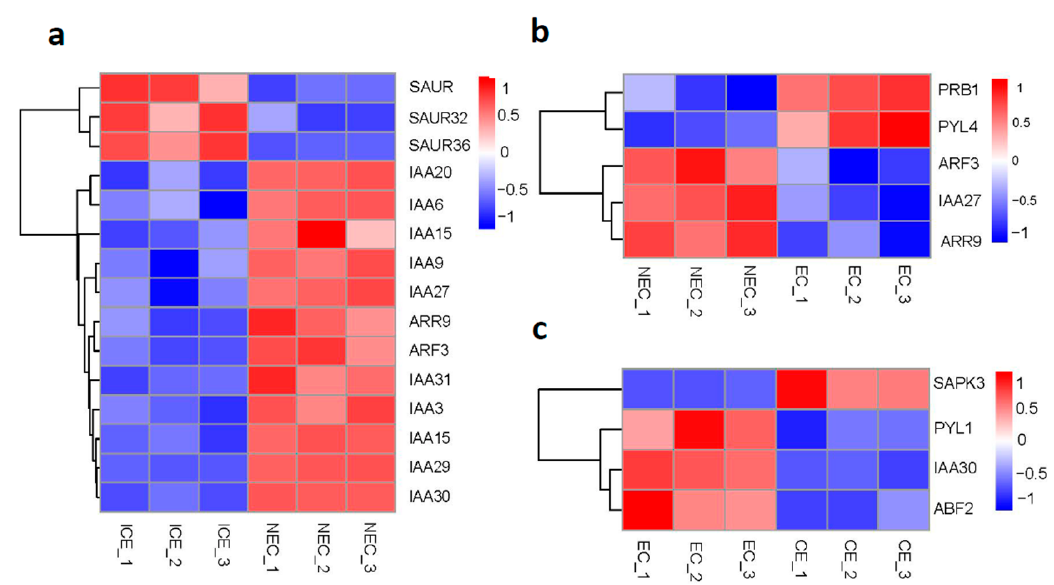
Figure 5. Plant hormone signal transduction genes in SE. ( a ) Expression of gene in ICE to NEC; ( b ) Expression of gene in NEC to EC; ( c ) Expression of gene in EC to CE. ∣ log2FC ∣ > 0.5. ICE_1, ICE_2 and ICE_3 represent three biological replicates.